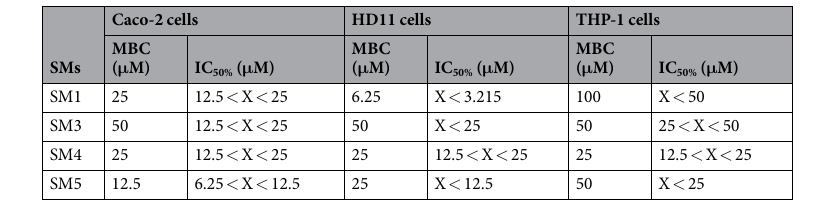
Table 3. Dose-response of the four selected small molecules (SMs) on Salmonella enterica subsp. enterica serotype Typhimurium in cell lines. MBC: minimal bactericidal concentration; IC 50% : 50% inhibitory concentration; X: estimated IC 50%